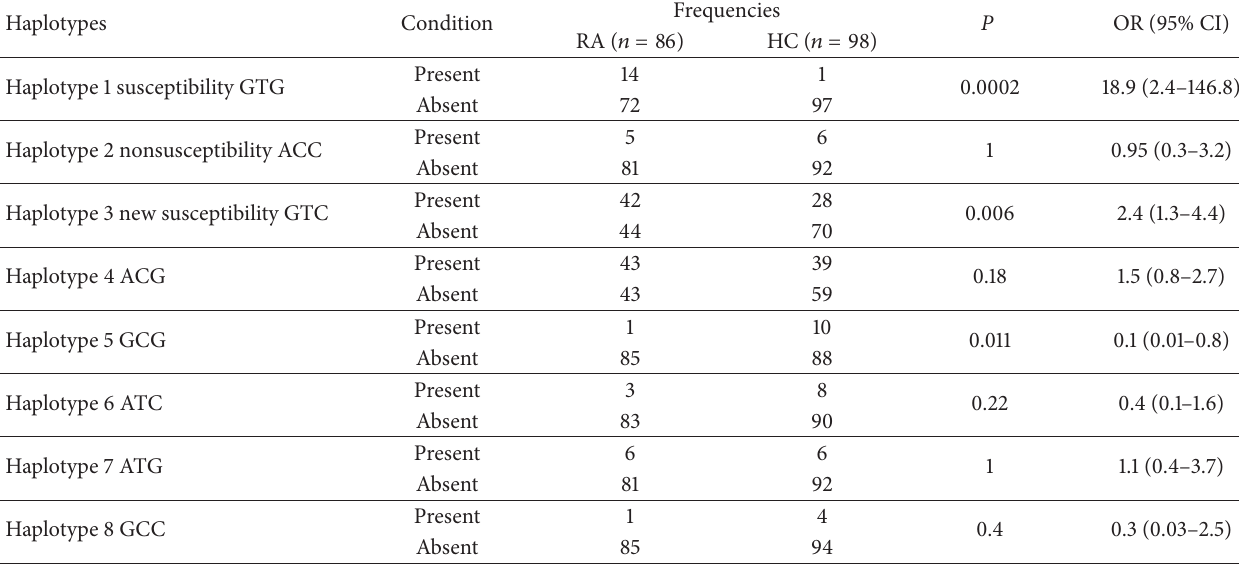
Table 4: Haplotype sequence and frequency of PADI4 gene SNPs (PADI4 89, PADI4 90, and PADI4 92) in healthy controls and RA patients.